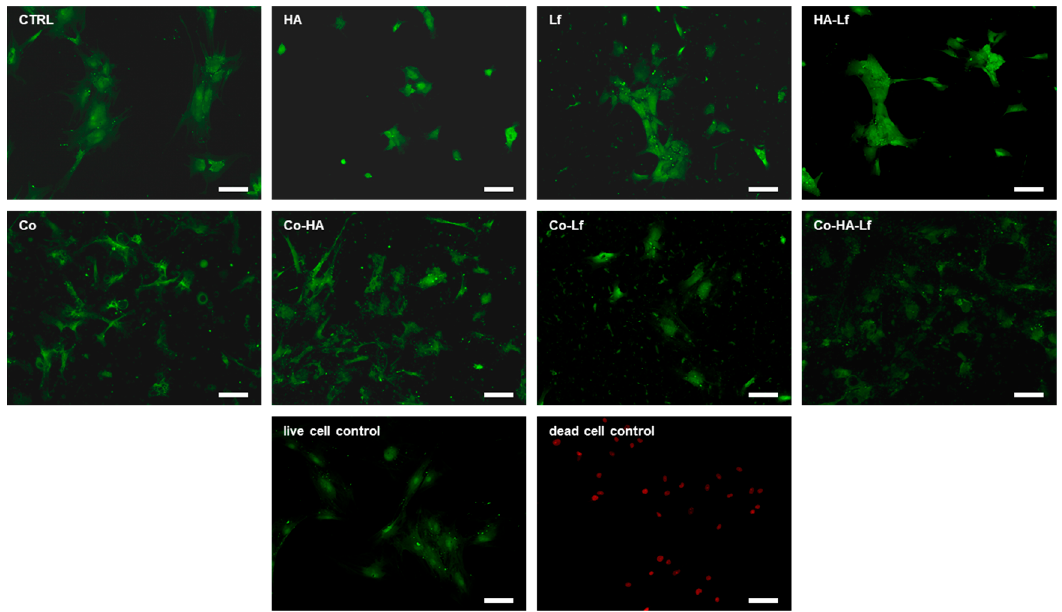
Figure 7. LIVE/DEAD assay. Green -fluorescent live cells and red-fluorescent dead cells are Figure 7. LIVE / DEAD assay. Green-fluorescent live cells and red-fluorescent dead cells are labelled labelled with Calcein AM and ethidium homodimer-1 respectively . Fluorescence microscopy with Calcein AM and ethidium homodimer-1 respectively. Fluorescence microscopy images of hMSCs images of hMSCs cultured on different surfaces for 72 h (10×). Scale bar 100 μ m. cultured on di ff erent surfaces for 72 h (10 × ). Scale bar 100 µ